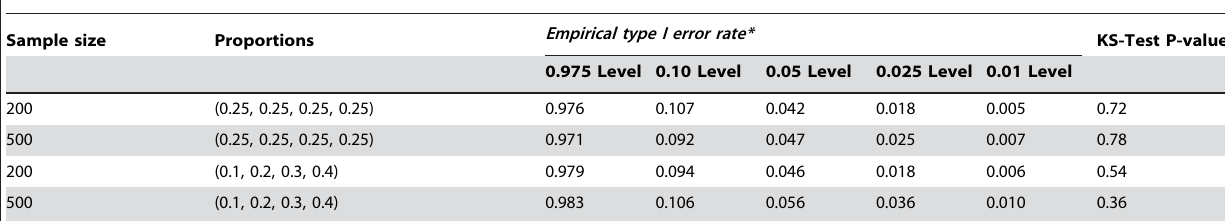
Table 1. Simulation results of the null distribution of chi-squared test.